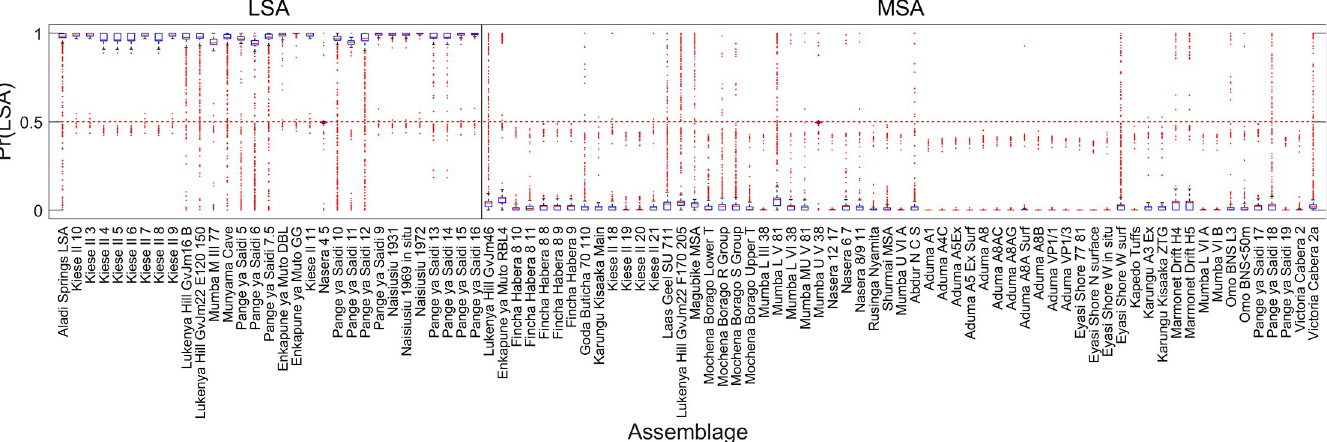
Confusion table for the overall classifications produced by the ensemble of 1,000 networks in the 2-way analysis. TP% = percentage of true positives. TN% = percentage of true negatives.